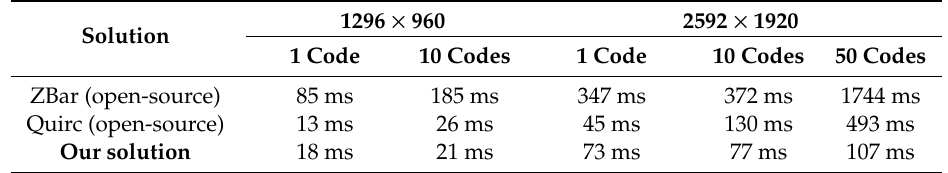
Table 2. Dependence of computational complexity on image resolution and number of QR codes in an